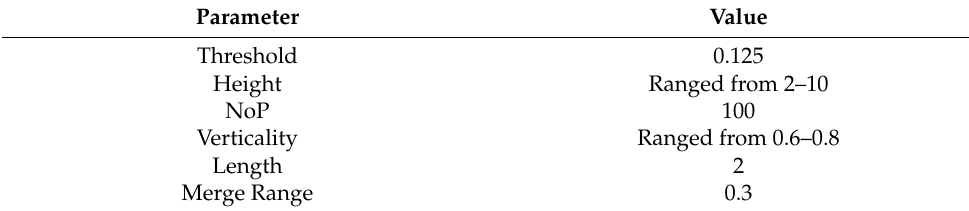
Table 4. Parameter values used in the SOTA